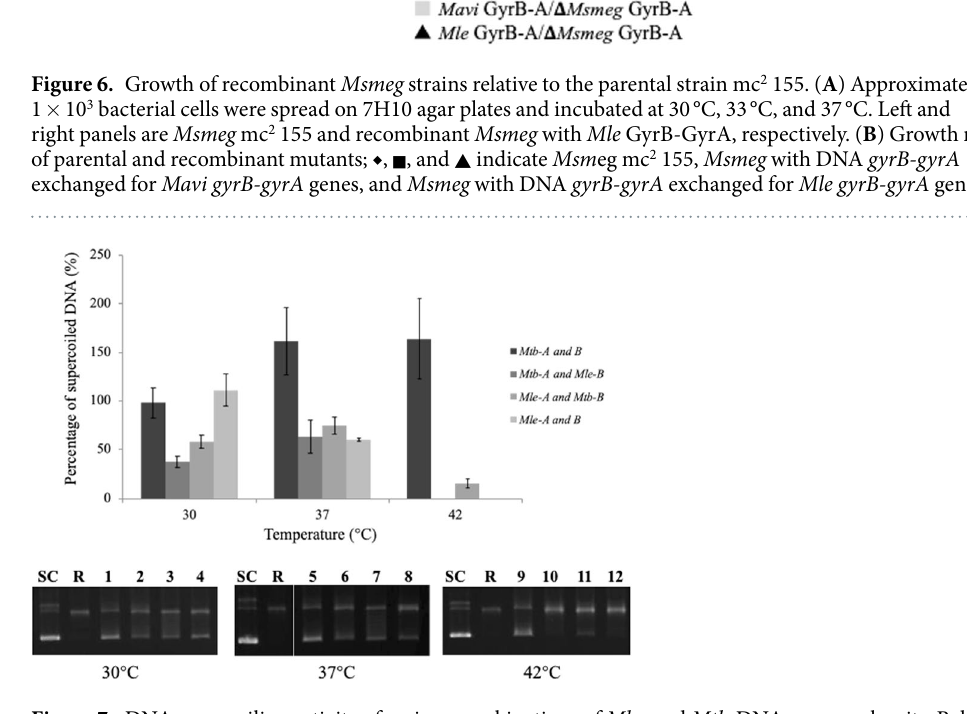
Figure 7. DNA supercoiling activity of various combinations of Mle - and Mtb -DNA gyrase subunits. Relaxed pBR322 DNA (0.3 μ g) was incubated for 1 h at 30 °C, 37 °C, and 42 °C with DNA gyrase reconstituted from 3 μ M of recombinant GyrA and GyrB subunits in various combinations. R and SC denote relaxed and supercoiled pBR322 DNA, used as a positive control for each enzyme